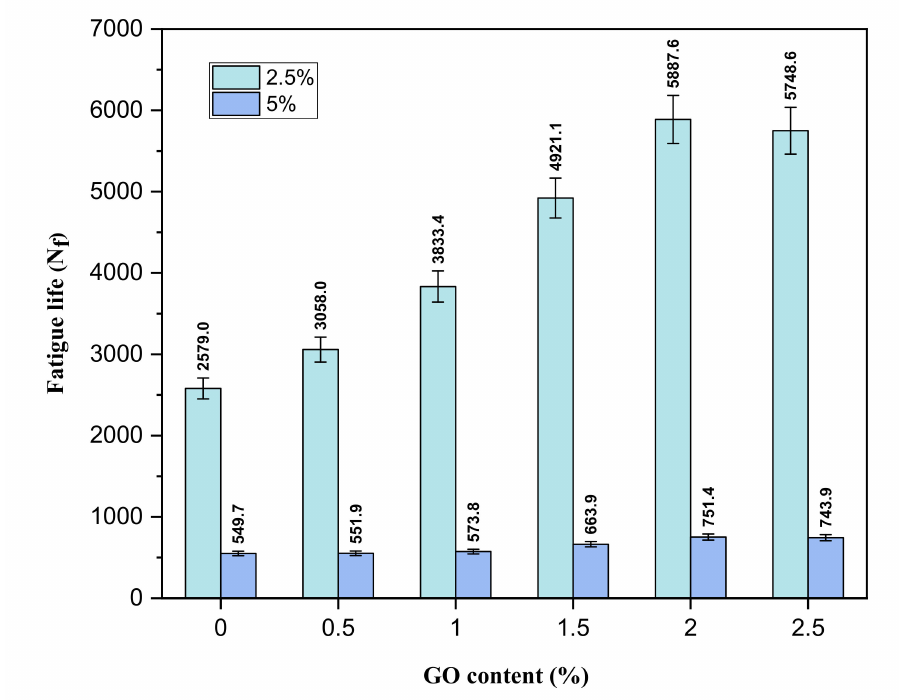
Figure 7. The fatigue life of GO-modified binders from the LAS test at strain levels of 2.5% and